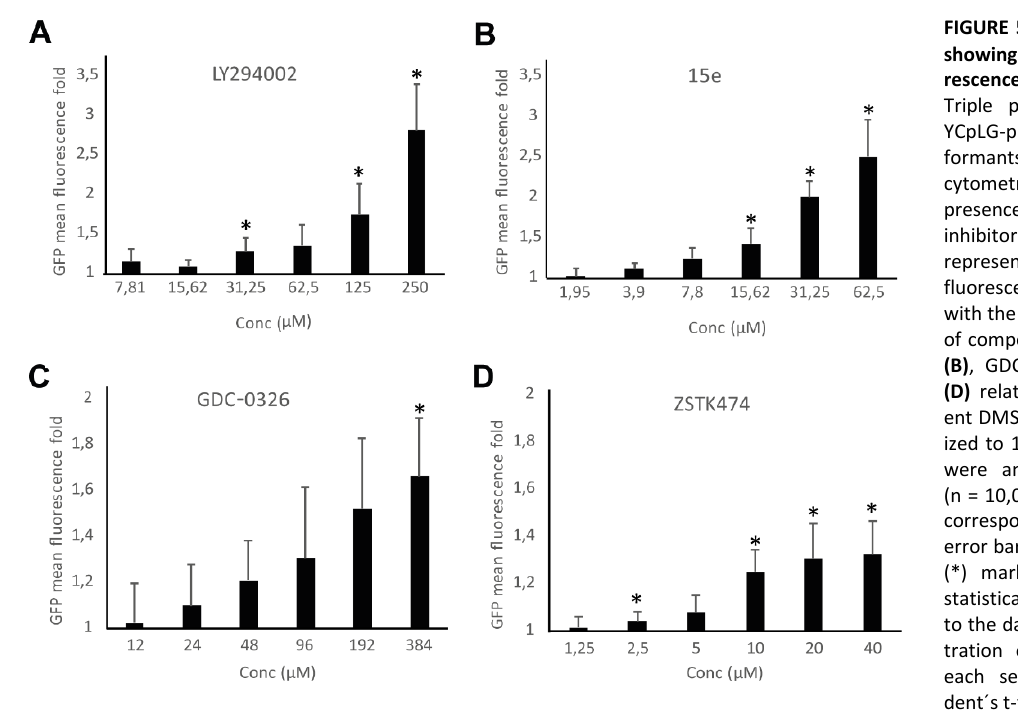
FIGURE 5: Dose-response graphs showing enhancement of fluo- rescence by the FLUPI assay. Triple pJMCS-LG3, pGNG1 and YCpLG-p110α trans- formants were analyzed by flow cytometry as in Fig. 4B in the presence of different doses of inhibitors as noted. The abscissae represent fold increase in green fluorescence of treated samples with the indicated concentrations